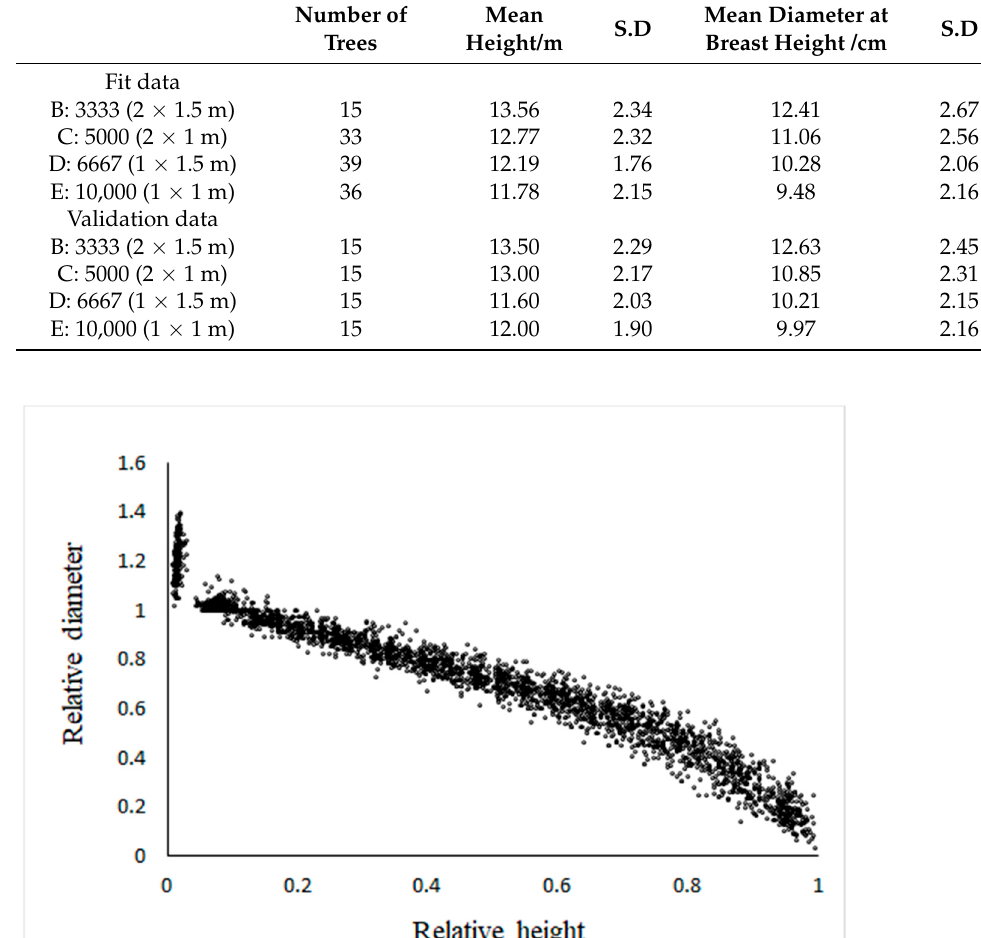
Table 2. Thirty stem taper equation selected as candidate models.